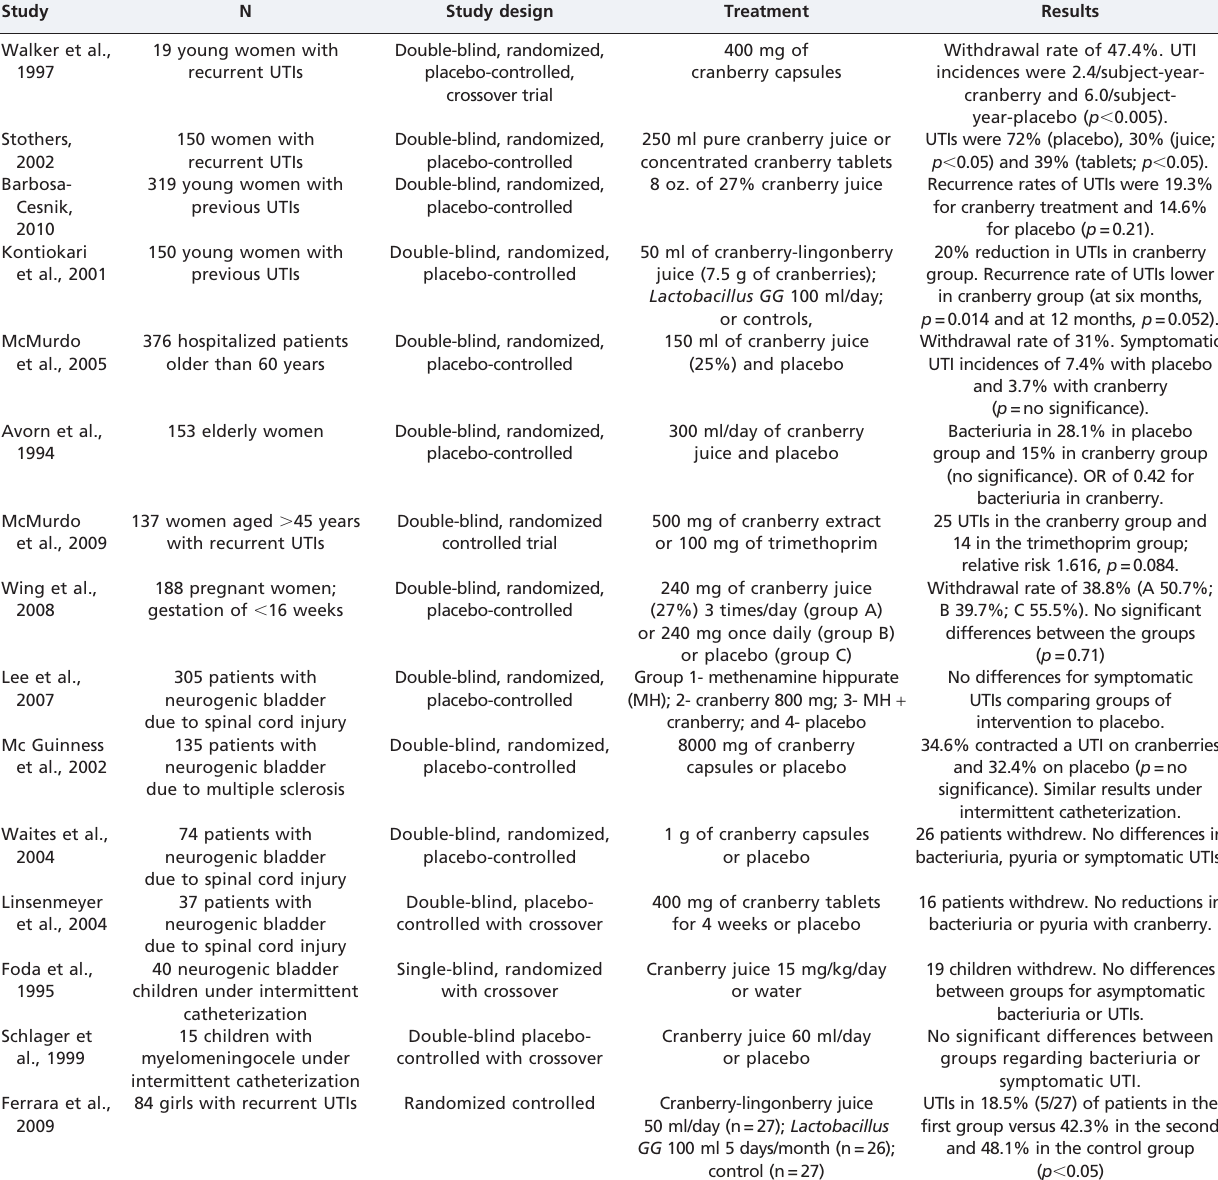
Table 2 - Clinical trials of cranberry products for UTI prevention in different